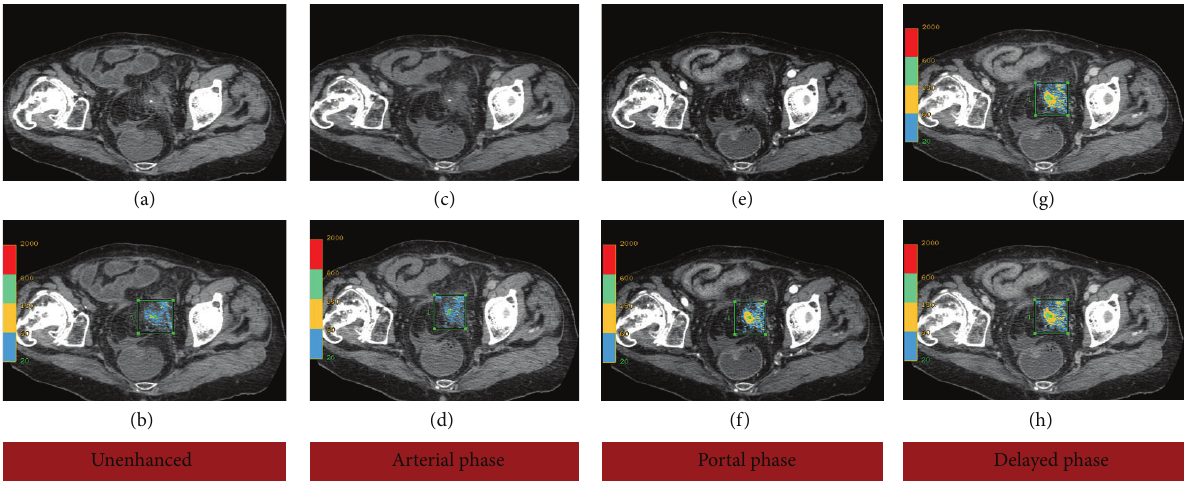
Figure 1: Oblique CT images before ((a), (b)) and after contrast medium administration in the arterial phase ((c), (d)), portal phase ((e), (f)), and delayed phase ((g), (h)) showing the foreign body and perifocal contrast-enhancement. In the lower images ((b), (d), (f), and (h)) a density color map has been superimposed using Advantage Workstation 4.5 (GE) to better depict the increase of HU in the different phases.